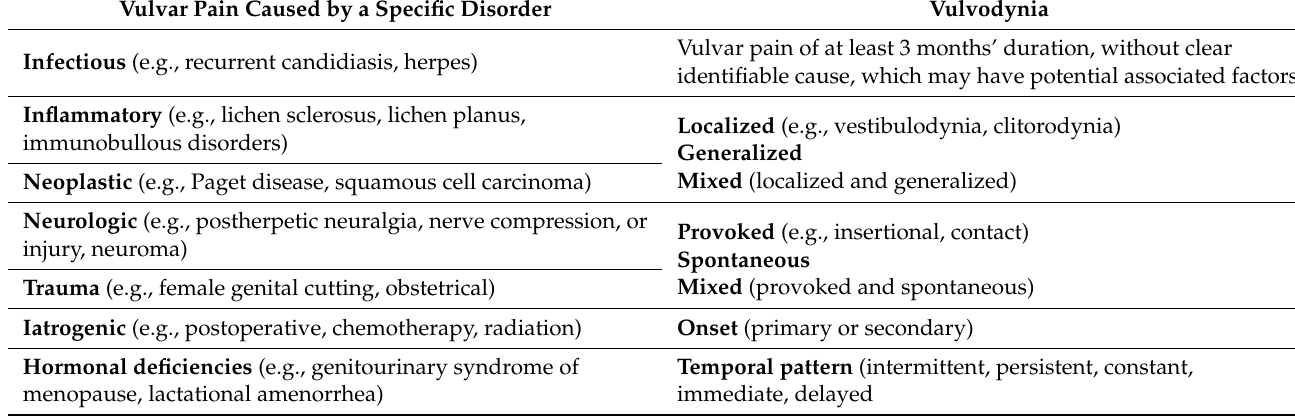
Table 1. 2015 Consensus Terminology and Classification of Persistent Vulvar Pain and Vulvodynia (ISSVD, ISSWSH, and IPPS) [11].